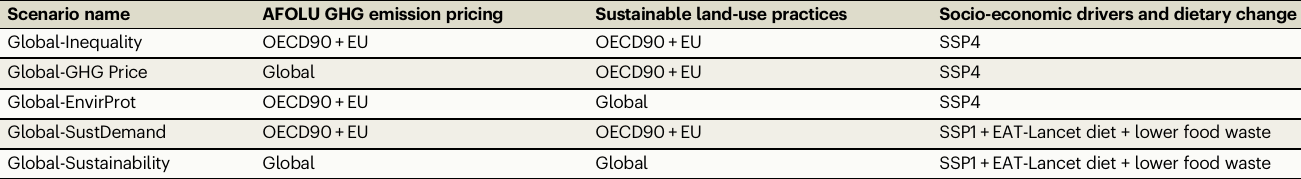
Table 1 | Summary of scenario de fi nitions Scenario name